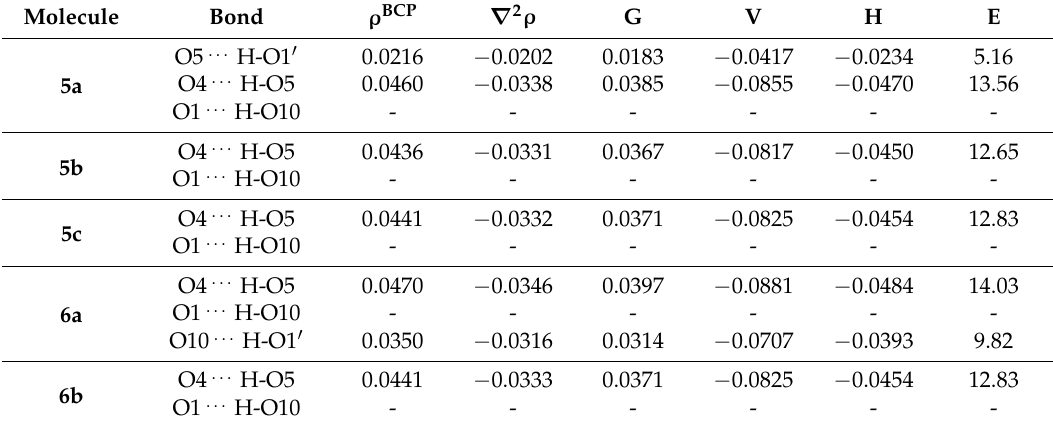
Table 14. Atoms-in-molecules parameters for 5 and 6 . Electron density at the critical point ρ BCP